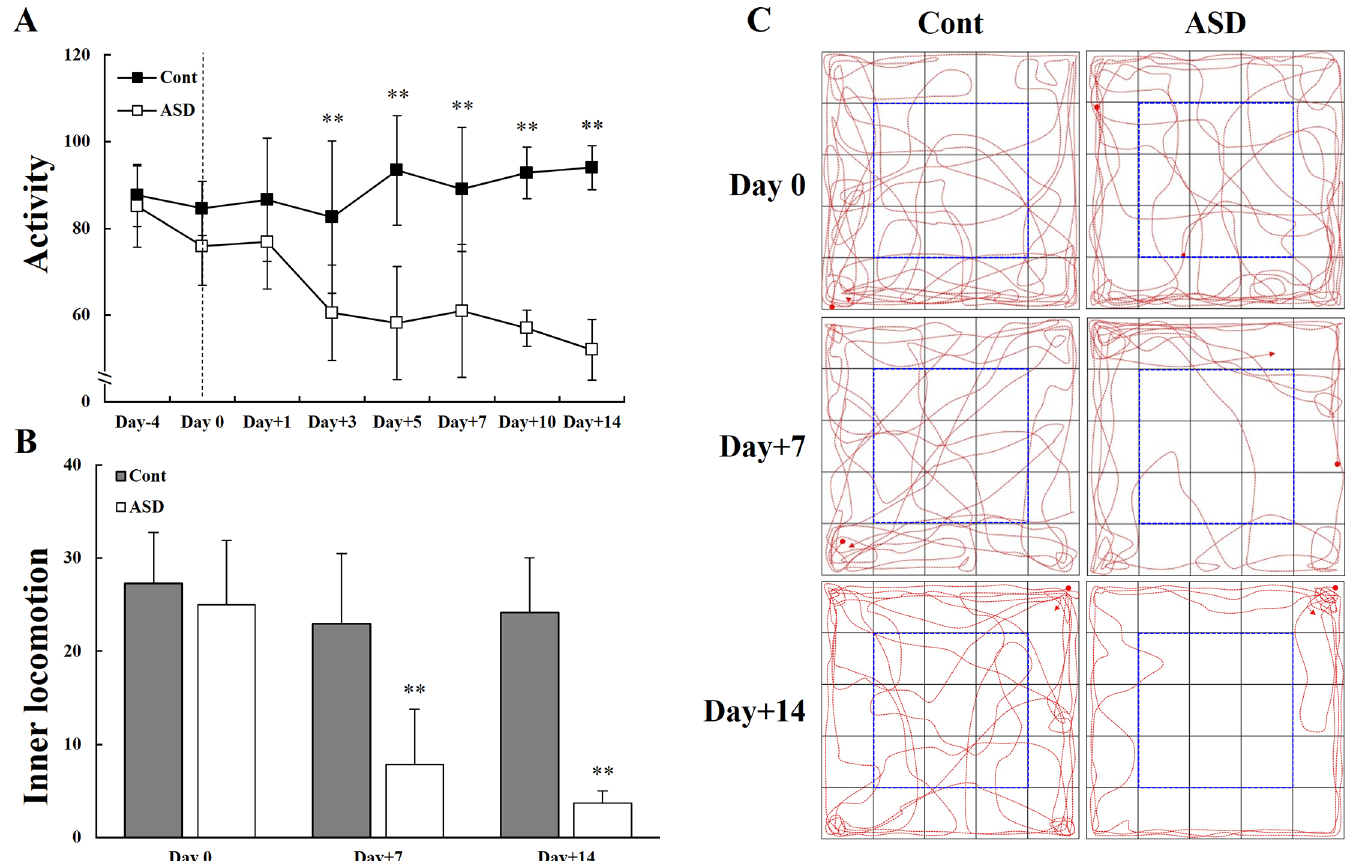
Fig 3. Comparison of exploratory activity in a non-social environment between control and PPA-treated groups. PPA-treated rats showed significantly reduced exploratory activity (A) and inner-square exploratory activity (B) during the whole PID period (days 0 to 14). (C) The locomotor activity of the control and PPA-treated rats was observed using a video tracking system. Data are presented as the mean ± SD. Cont, control rats; ASD, PPA-treated rats. (cid:3) p < 0.01: vs .